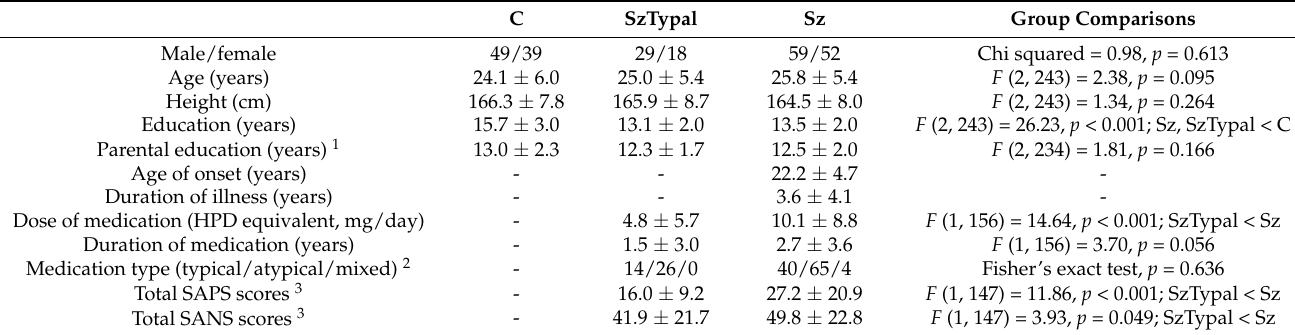
Table 1. Demographic/clinical parameters and brain measurements of